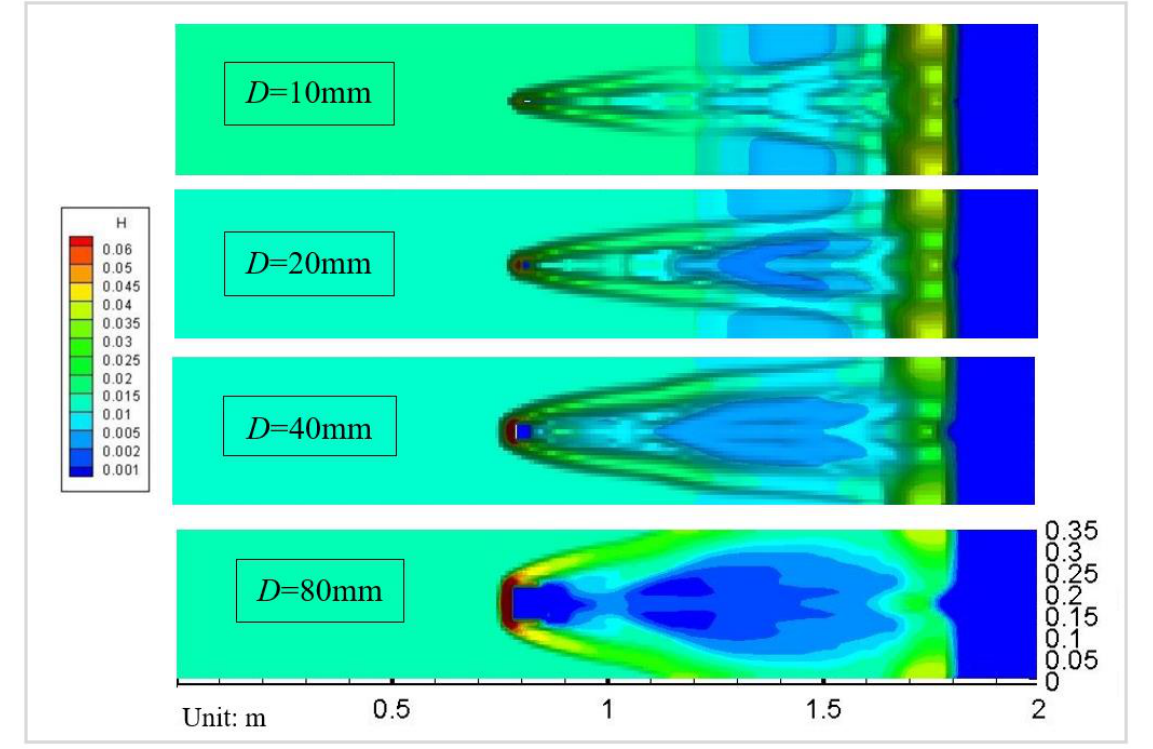
Figure 3. Configurational comparison of an avalanche hitting a square obstacle with different side lengths at time t = 3.5 s.